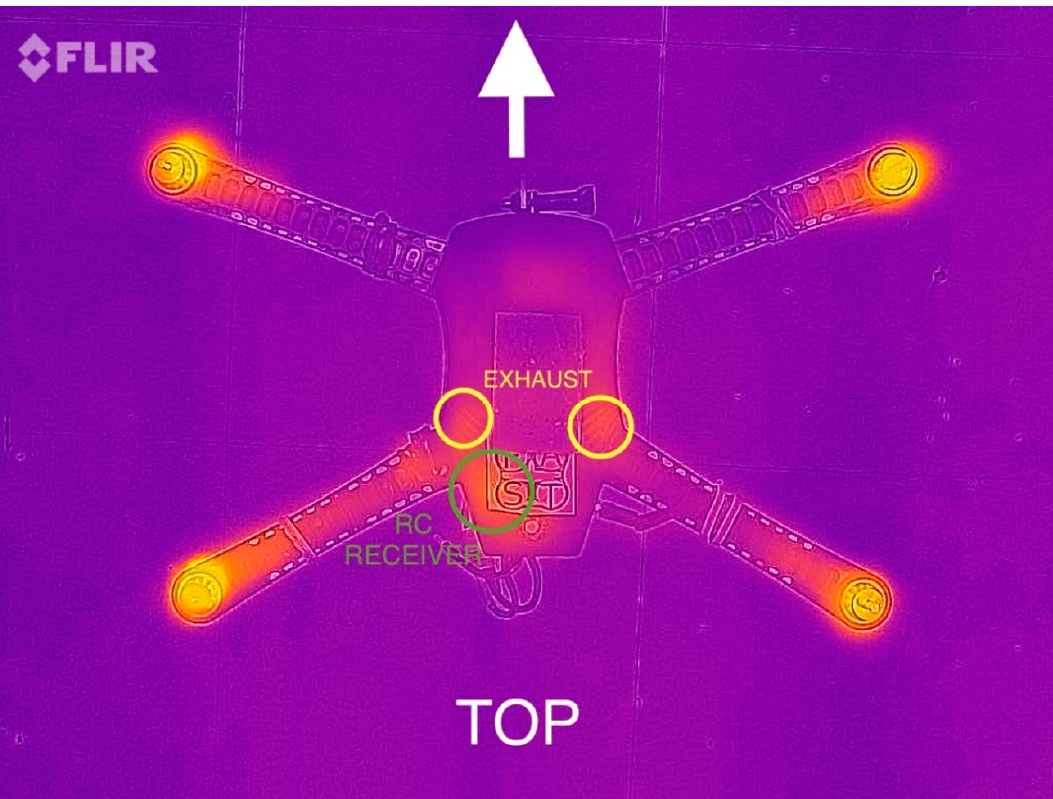
Figure 9. Infrared photograph of the top of the Iris+ during a laboratory experiment where the motors of the UAV were running, but no propellers were attached. Warmer elements are indicated in yellow. The locations of the exhaust vents (yellow circles) and the radio-control receiver (RC receiver, green circle) are indicated. The white arrow indicates the front of the UAV.